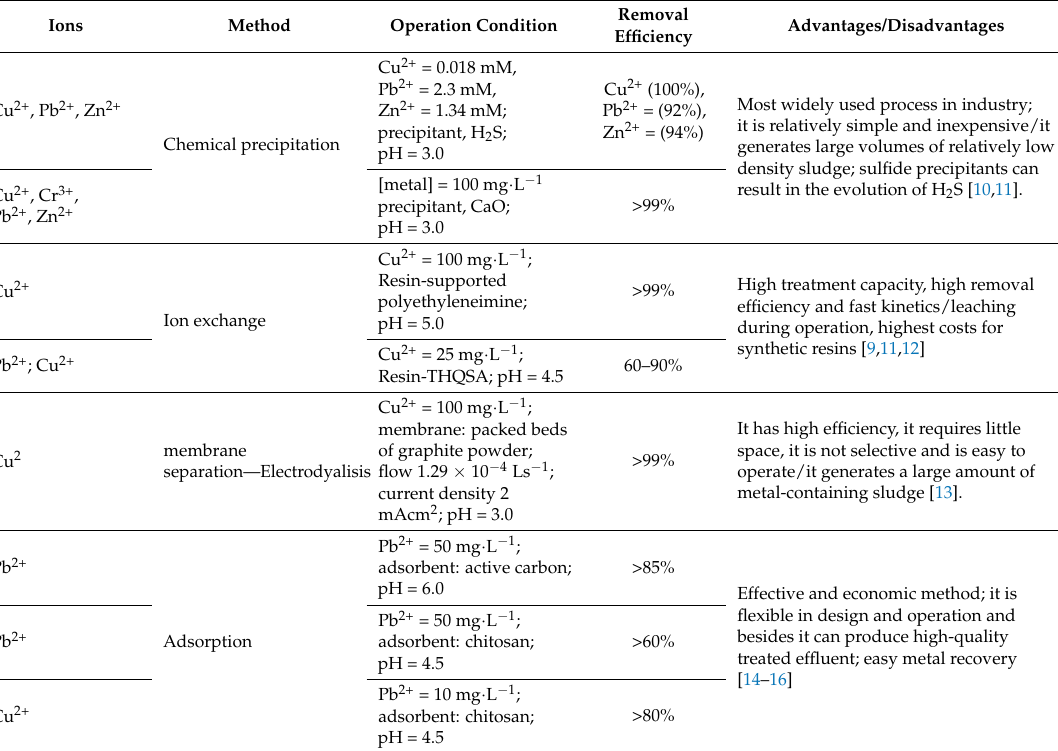
Table 1. Some methodologies for removal of Pb 2+ and Cu 2+ from